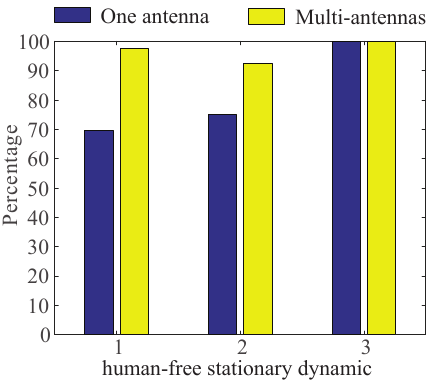
Figure 7. The influence of the number of antennas on the detection